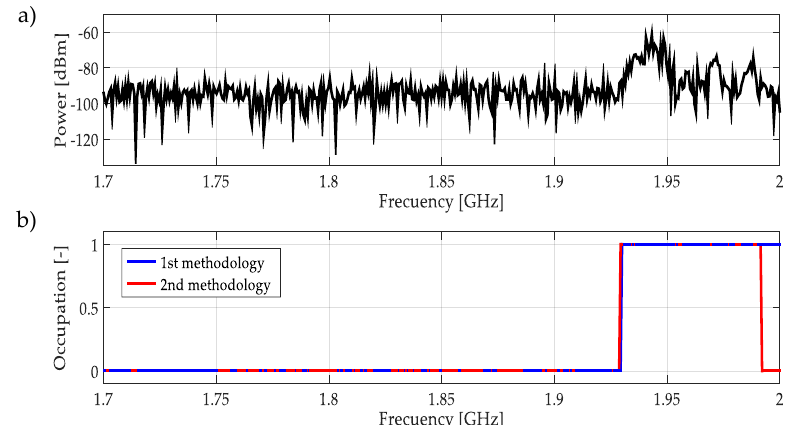
Figure 23. ( a ) A real signal obtained from the frequency band [902 – 928] MHz. ( b ) The result of